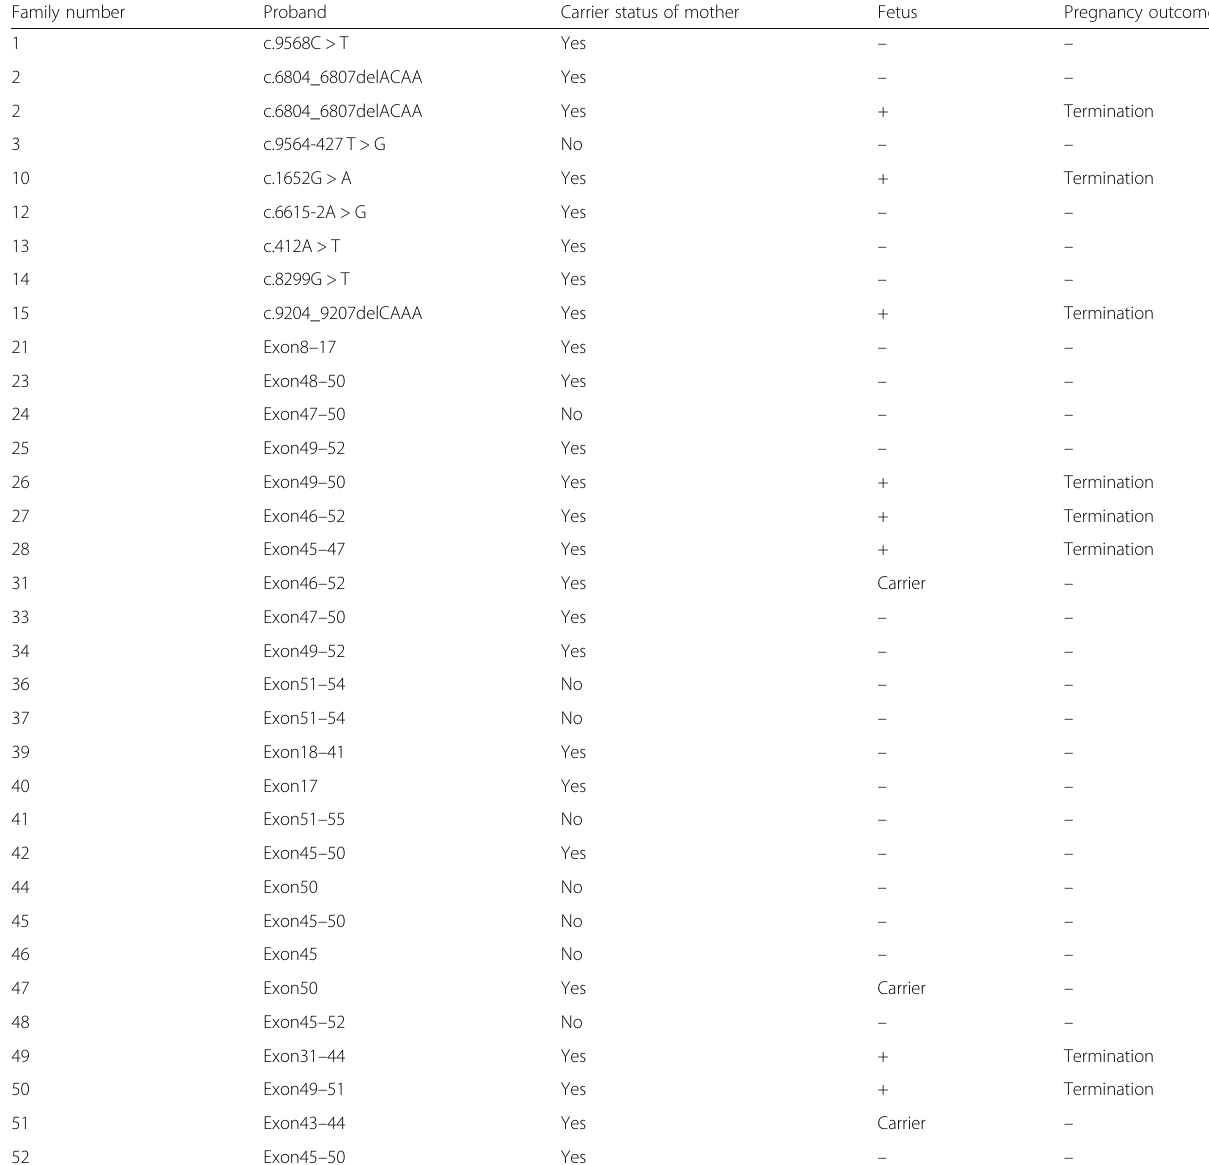
Table 3 Prenatal diagnosis of 34 fetuses in high-risk families with DMD family history Family